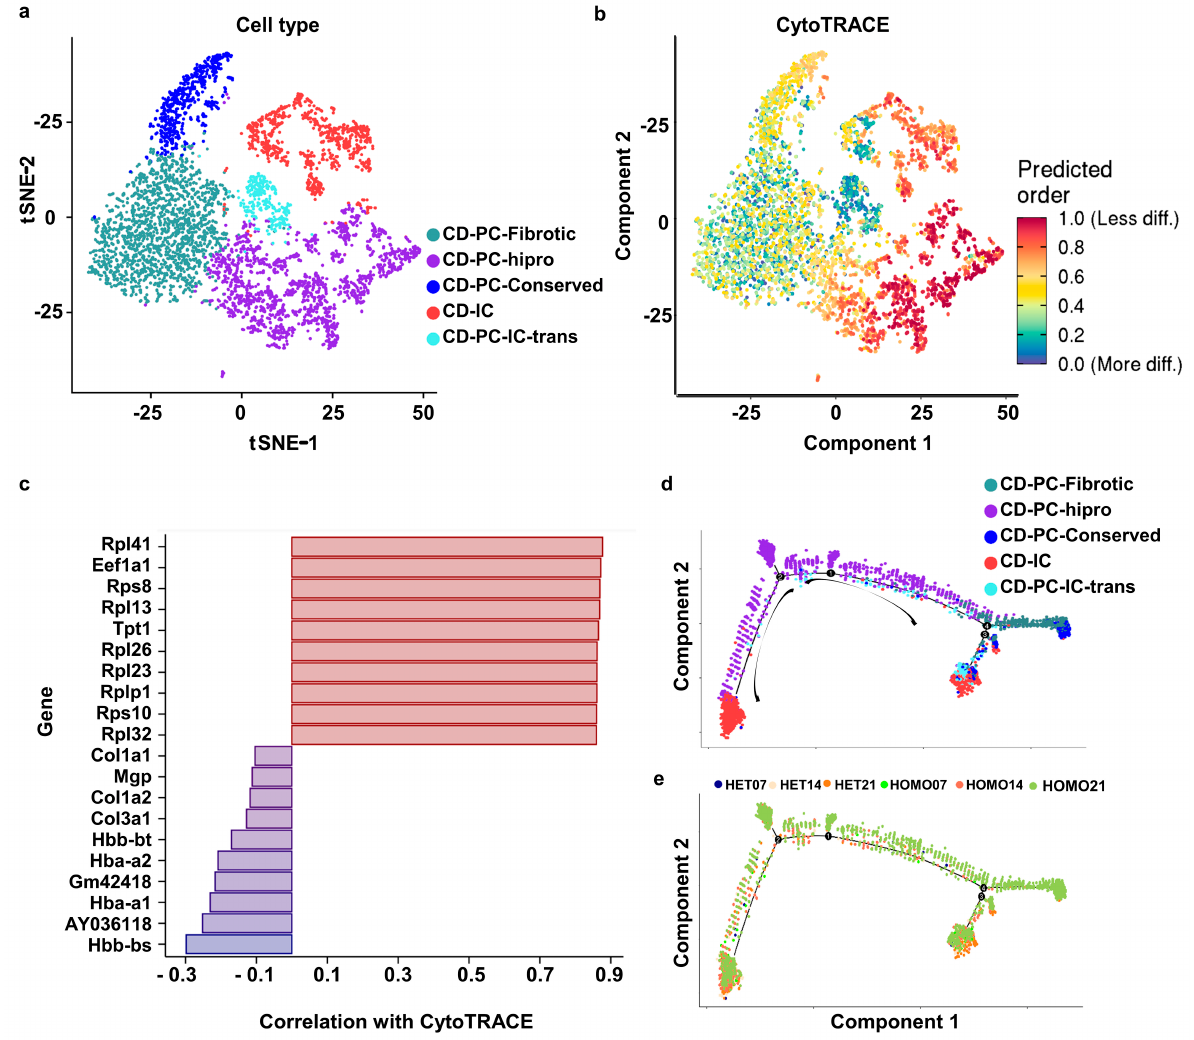
Figure 4. CytoTRACE and Monocle cell trajectory analysis of collecting duct cell differentiation from Pkd1 heterozygous and homozygous knockout kidneys day 7 (pre-initiation stage), day 14 (progressive stage) and day 21 (late stage). ( a ) tSNE visualization of renal collecting duct cells merged from the six kidney groups, which are colored by transcriptional cluster, with each color representing a different cell subtype. ( b ) Projection of the results from CytoTRACE on the integrated data of collecting duct cells by Seurat. A higher score indicates less differentiated states. ( c ) The top 10 (less differentiated; red) and bottom 10 (most differentiated; blue) genes in this dataset based on their correlation with CytoTRACE. ( d , e ) Cell trajectory maps of collecting duct cells highlighting the contribution of cells coming from each subtype ( d ) and each group ( e ). Arrows show the trajectory initiated from CD-PC-hipro cells ( d ). Each color in d represents one cell subset of collecting duct cells. Each color in e represents the original kidney group of collecting duct cells. 3.4. Reconstruction of Collecting Duct Cell Trajectories during Cyst Development in Pkd1 Homozygous Knockout Kidneys During tissue development and throughout life, cells can be transited from one functional “state” to another. Cells in different states undergo a process of transcriptional re-configuration, with some genes being silenced and others being activated, thus driving cell transition between states. These transient states are often hard to characterize in purified cells since these cells are in more stable endpoint states. To prove the cell